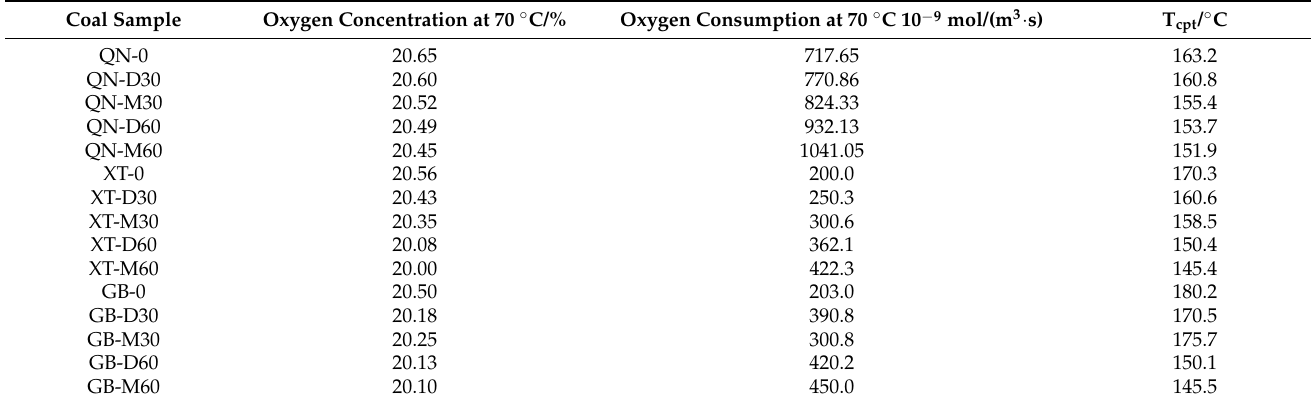
Table 3. Oxygen consumption rates and CPTs of coal samples at 70 ◦